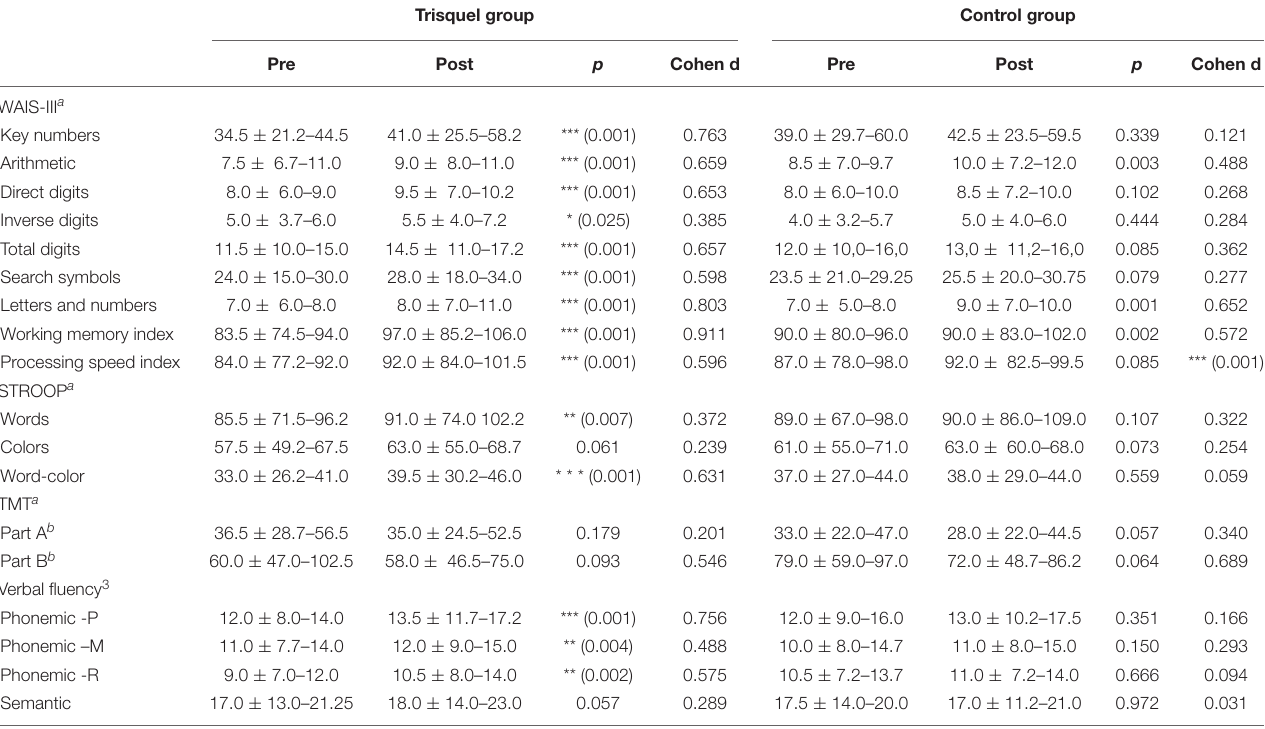
TABLE 3 | Intragroup comparison with respect to cognitive performance.